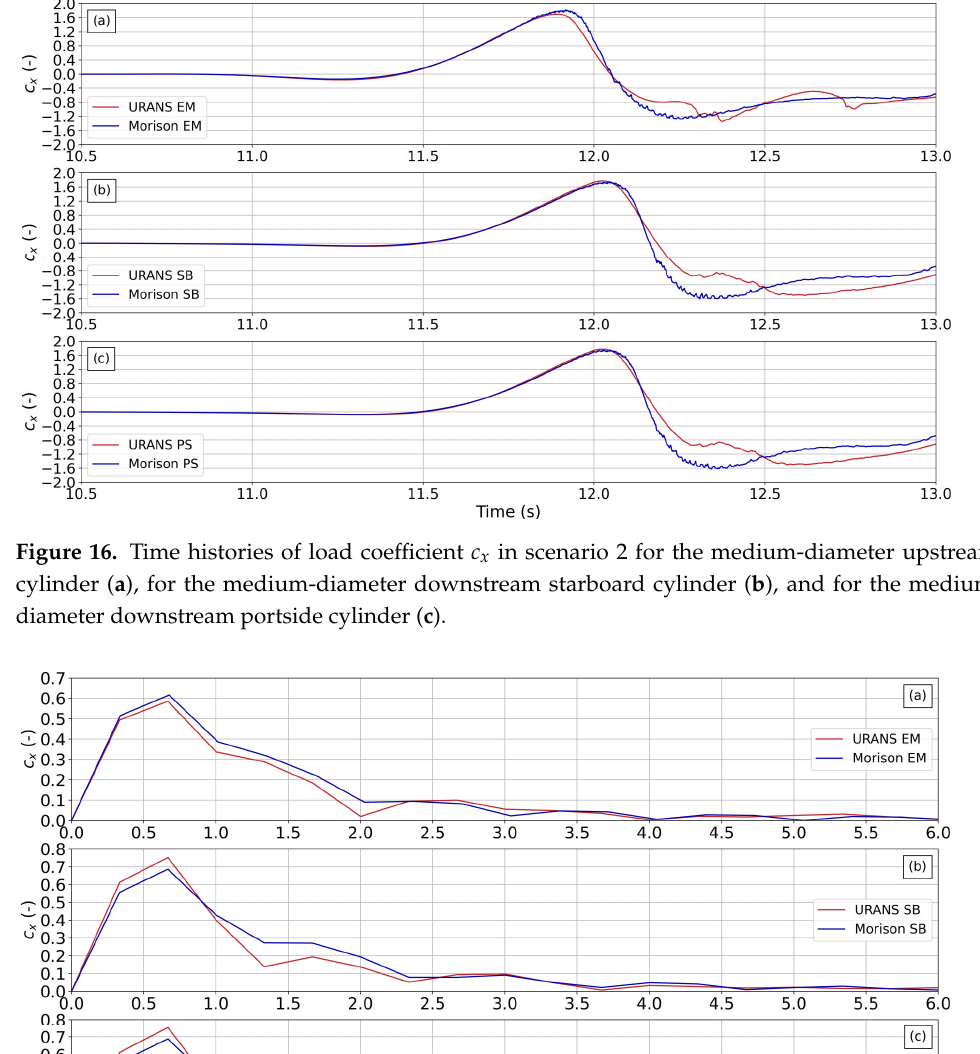
Figure 16. Time histories of load coefficient c x in scenario 2 for the medium ‐ diameter upstream cyl ‐ inder ( a ), for the medium ‐ diameter downstream starboard cylinder ( b ), and for the medium ‐ diam ‐ eter downstream portside cylinder ( c ).